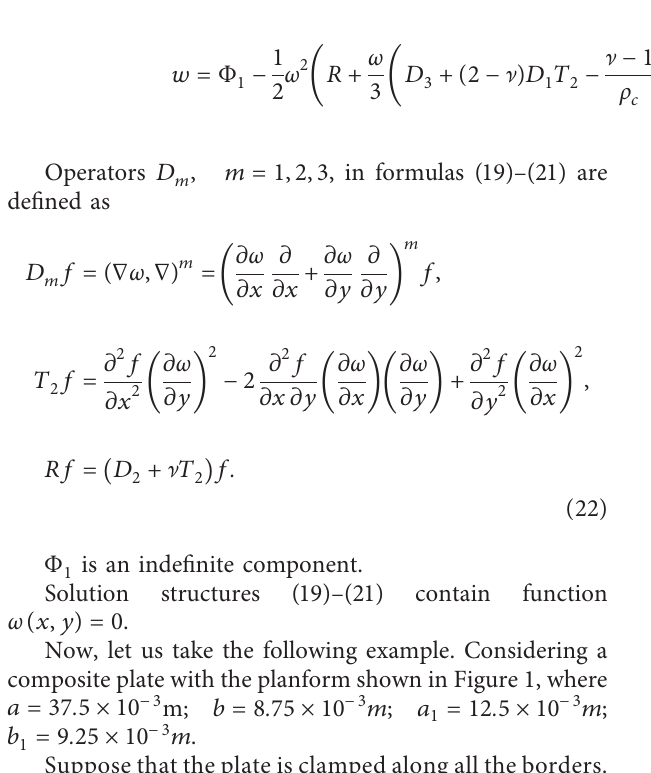
Figure 6: Numerical simulation: mesh and clamped edges.